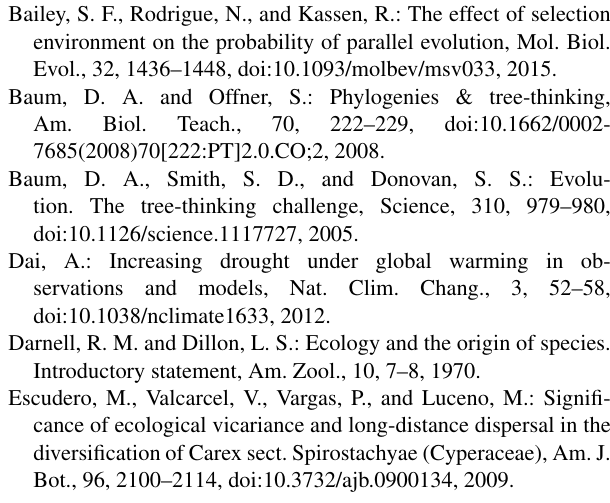
Table S1 index of divergence ( D) from the phylogeny- based SEEVA evaluation of spruce species worldwide. Table S2 index of divergence ( D) from the morphology- based SEEVA evaluation of spruce species